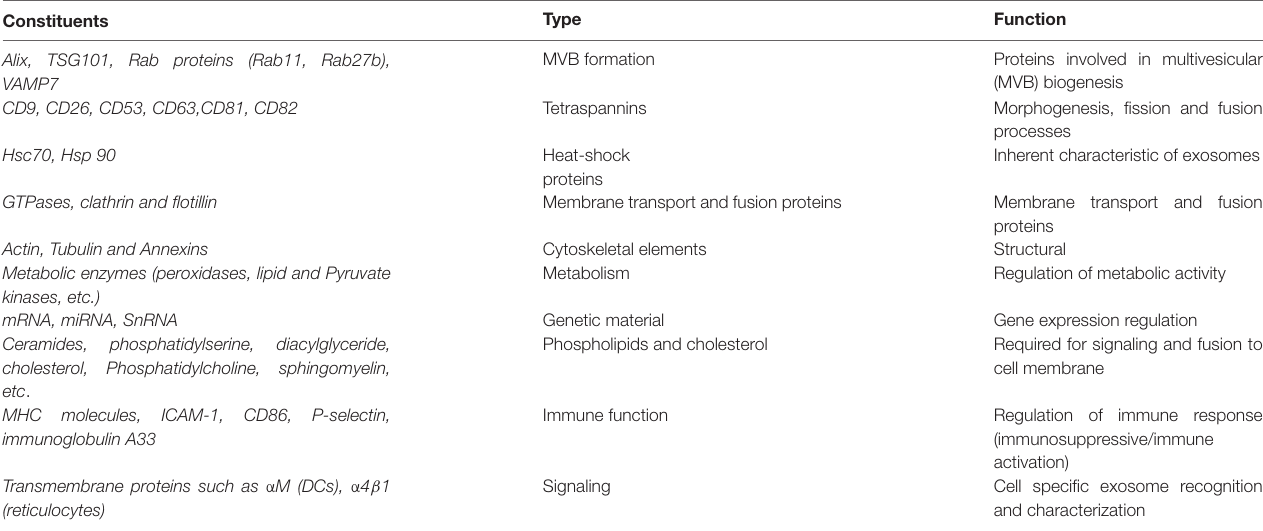
TABLE 1 | Table summarizing information on exosomal